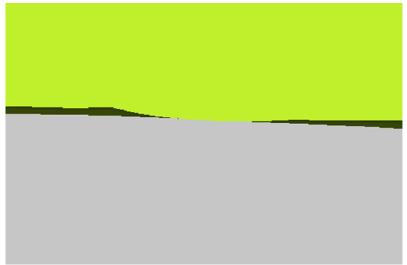
Figure 8. Sealing structure of the casing connection.